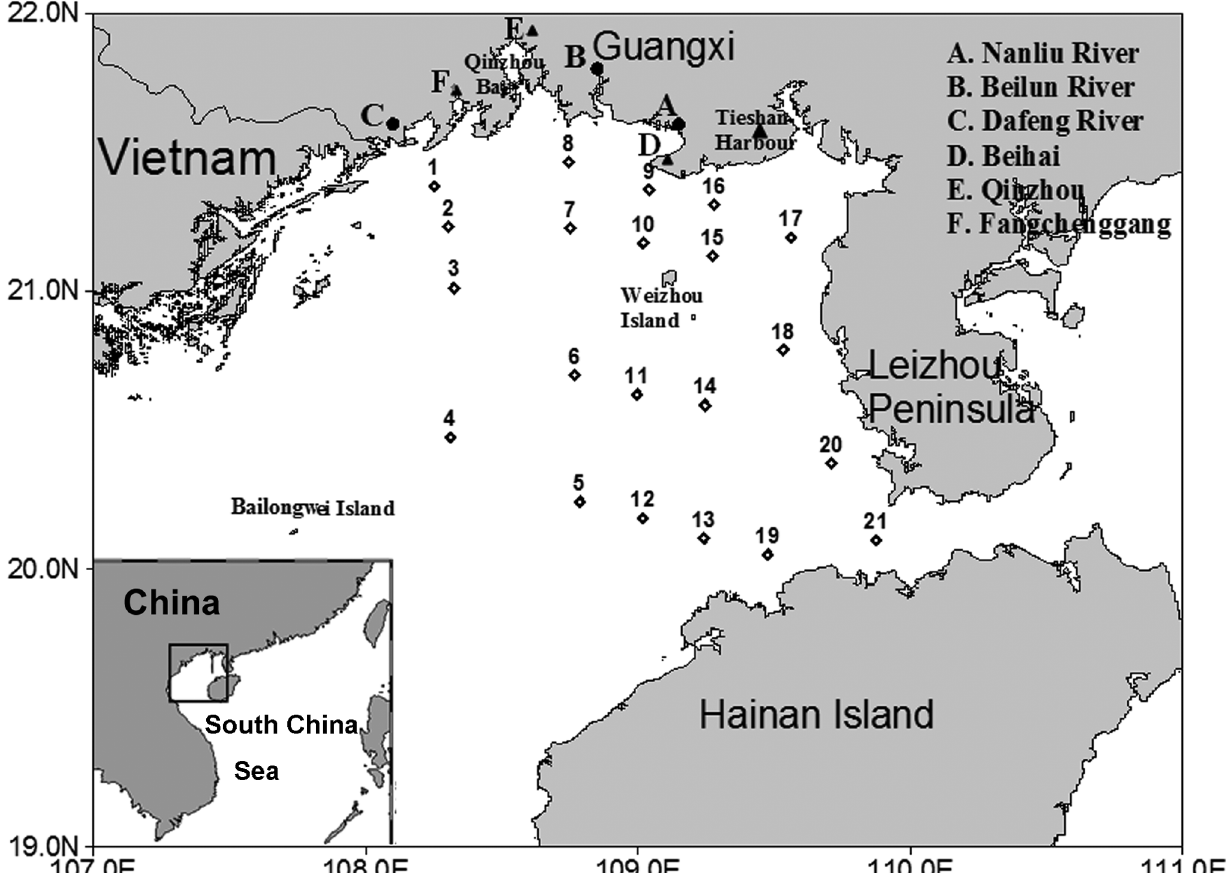
Figure 1. Sampling stations of planktonic ciliates in the northern Beibu Gulf in August 2011. (TIFF).